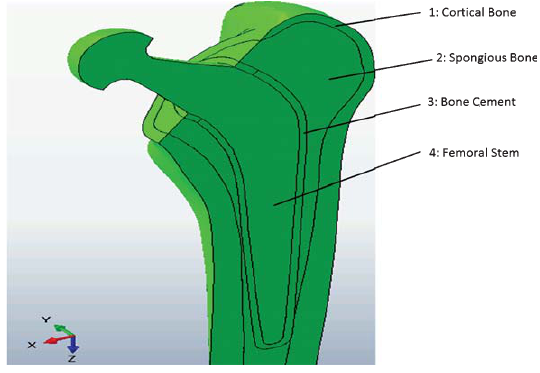
Fig. 2. Longitudinal section of the reconstructed prosthesis.